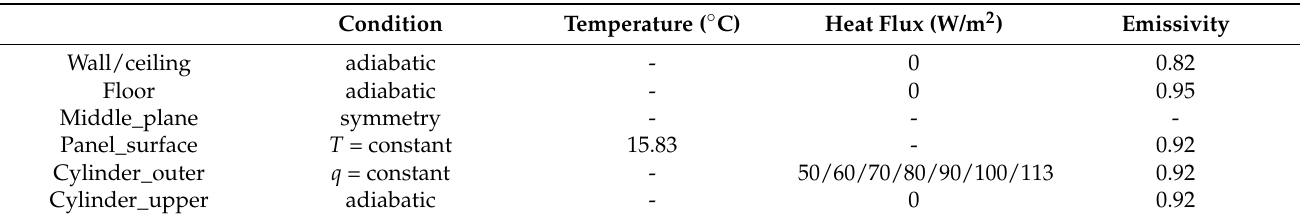
Table 3. Boundary condition and emissivity of each surface.